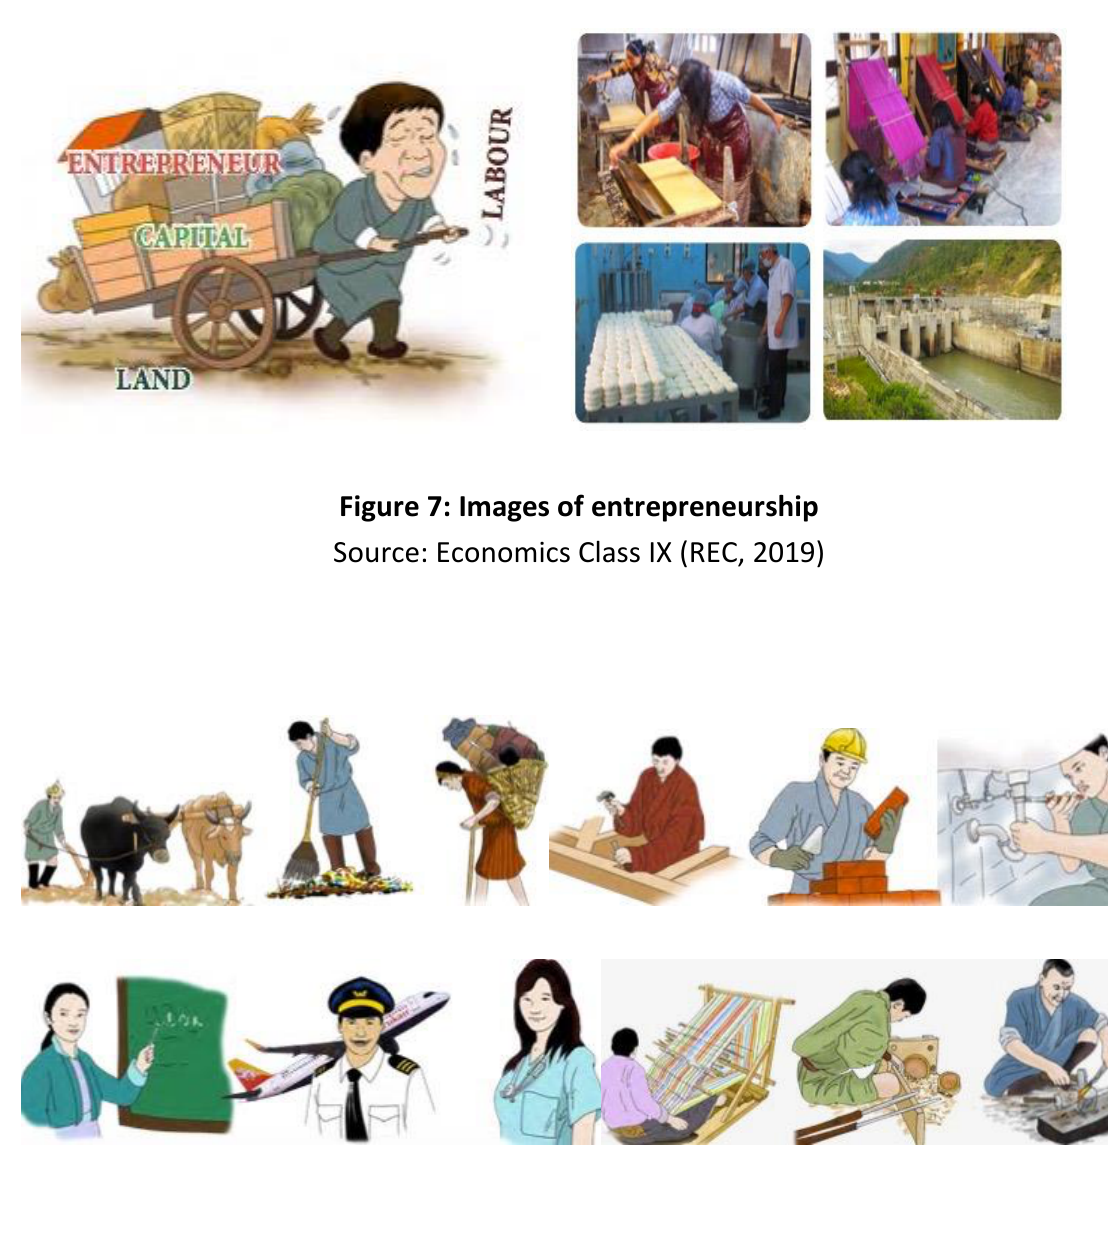
Figure 8: Images of entrepreneurship Source: Economics Class X (REC,